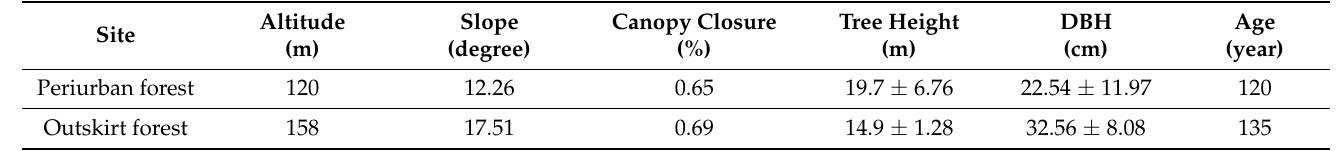
Table 1. Basic features of the experimental